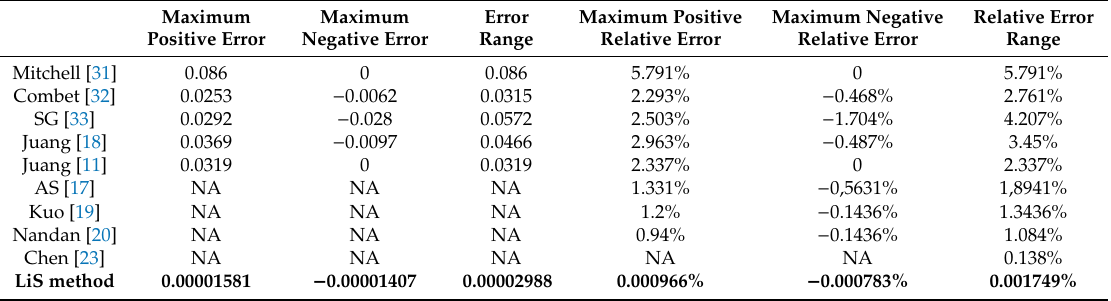
Table 6. Comparison of accuracies achieved using the proposed LiS method with selected conversion